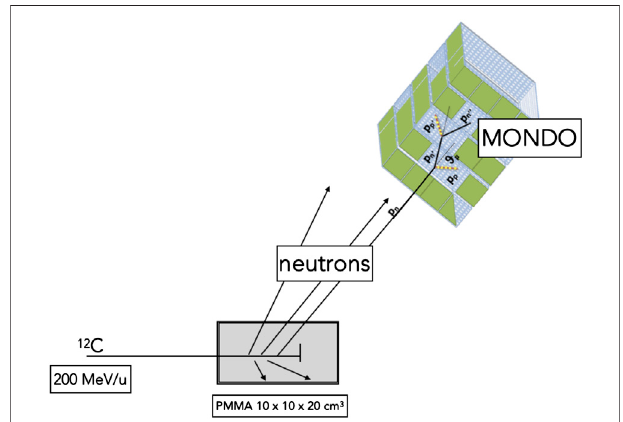
FIGURE 1 | Schematic representation of the detection of a DES event in MONDO for a neutron produced in a target by a particle therapy beam. The beam (p or 12 C) interacts with the target (e.g., patient tissues or material placed on the beamline) producing neutrons detectable in MONDO. The neutron emission point can be measured once the neutron four-momentum reconstruction is performed and the relative position of the detector and the target is